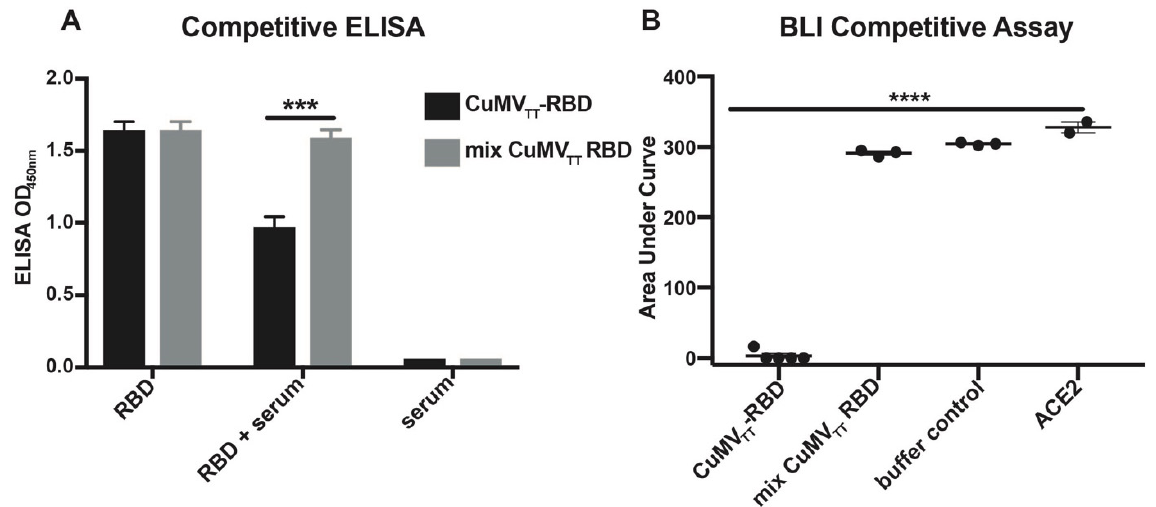
Figure 3. Sera of mice immunized with the CuMV TT –RBD vaccine inhibit the interaction of the RBD to ACE2. ( A ) Competition ELISA results using immobilized ACE2 (1 μ g/mL). Five mouse sera per group (1:40 dilution, d31 after first immunization) were incubated with RBD–His (0.15 μ g/mL) before adding to ACE2. ( B ) Competition BLI results using the RBD immobilized on a biosensor. Sera of immunized mice at d31 after first immunization (1:20 dilution) were used to compete for the binding of ACE2 (50 nM) to the RBD. Shown are a scatter plot of individual mice ( n ≥ 3/group), and area under the curve (binding of ACE2 to the RBD with time) was assessed. Statistical analysis was performed with unpaired t -test, p ≤ 0.005 (***), p ≤ 0.001 (****).